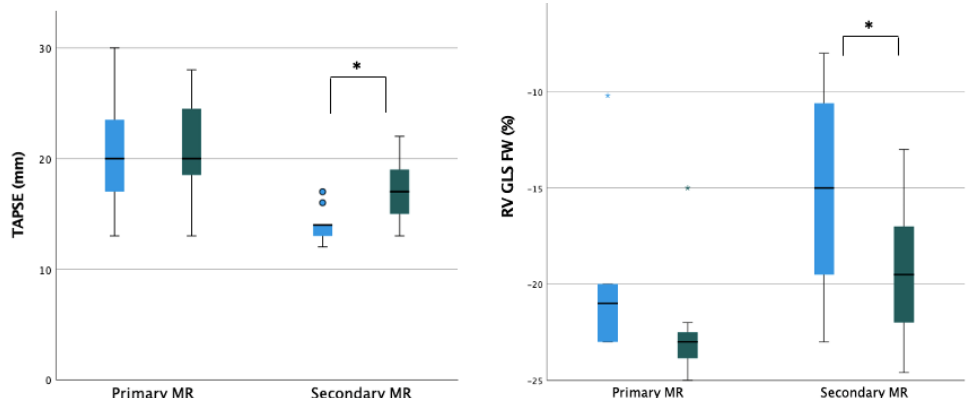
Figure 3. Ventricular and atrial remodeling after percutaneous mitral valve repair according to MR etiology. Legend: EPSPAP, estimated peak systolic pulmonary artery pressure; FAC, fractional area change; iLAV, indexed left atrial volume; iLVM, indexed left ventricular mass; iLVEDV, indexed left ventricular end-diastolic volume; iLVESV, indexed left ventricular end-systolic volume; LVEDD, left ventricular end-diastolic diameter; RA, right atrium; RVD, right ventricular diameter; RV GLS FW, right ventricle free wall longitudinal strain; TAPSE, tricuspid annular plane systolic excursion; TR, tricuspidal regurgitation. * = p < 0.05.